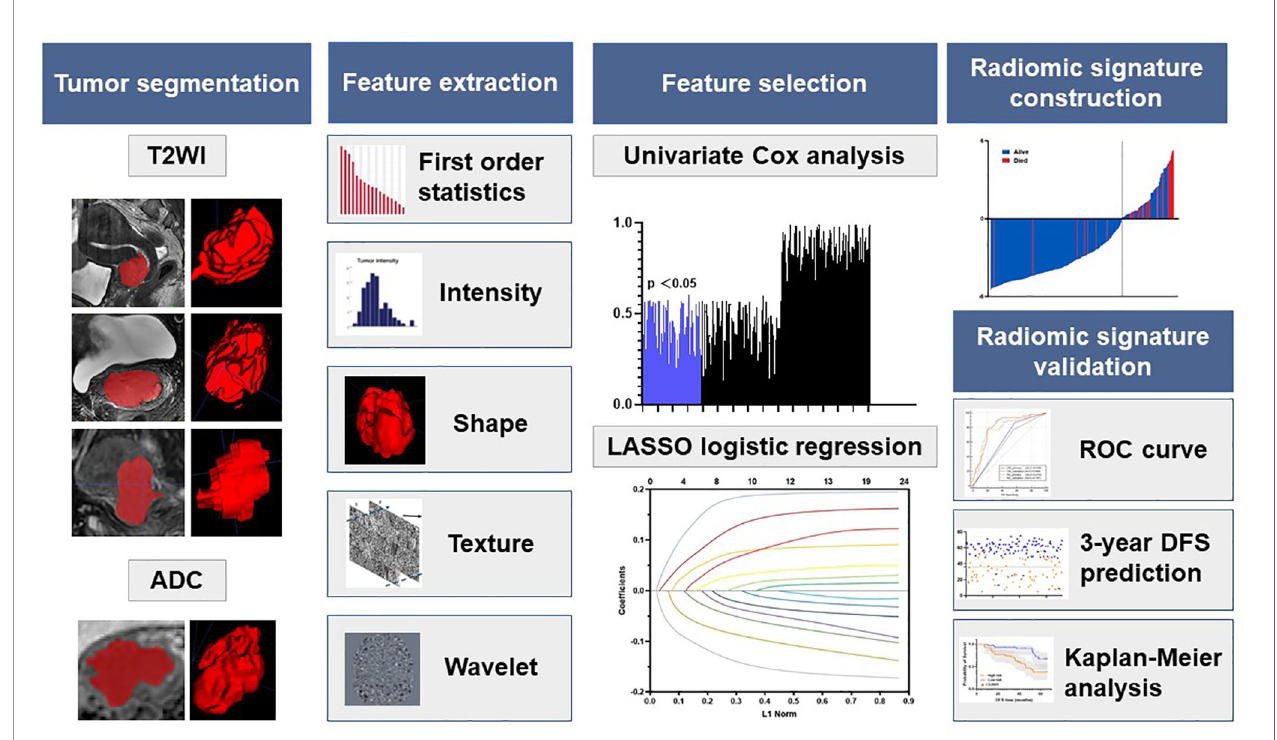
FIGURE 2 | Radiomics framework of predicting the DFS of LACC patients. DFS represents disease-free survival; LACC represents locally advanced cervical cancer; ROC represents receiver operating